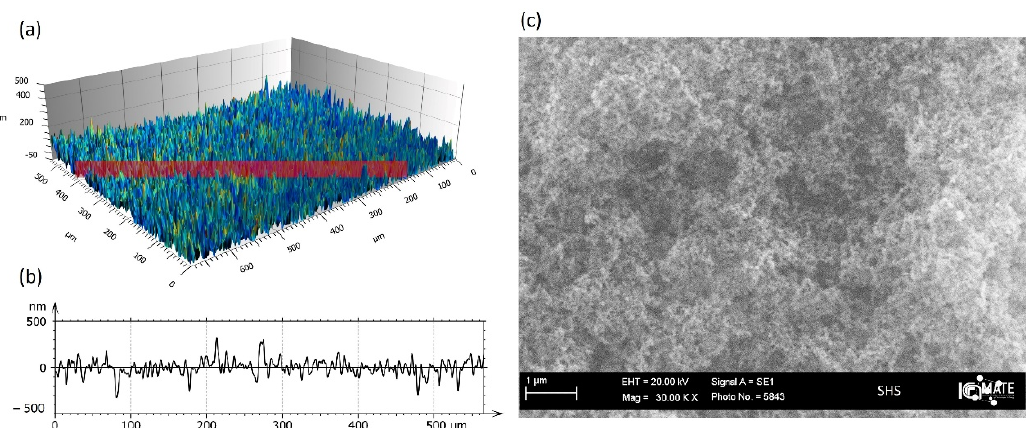
Figure 1. Three-dimensional image of SH sample ( a ) and correlated roughness profiles ( b ) acquired by 3D interferometric and confocal profilometer Sensofar S-Neox: Sa = 70 ± 2 nm. Representative SEM image of SH sample microstructure at 30 Kx ( c ), reference bar 2 µm.